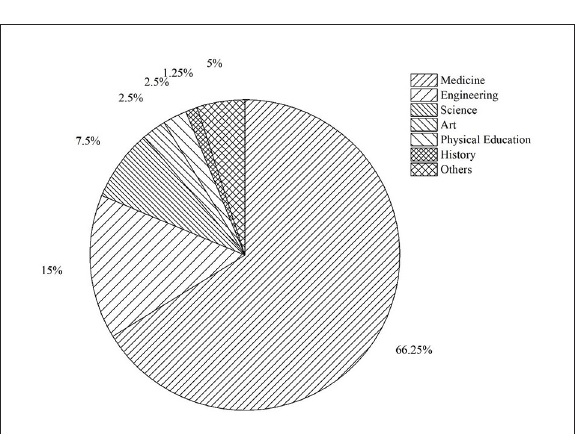
FIGURE3 The professional statistics situation of VR application in higher